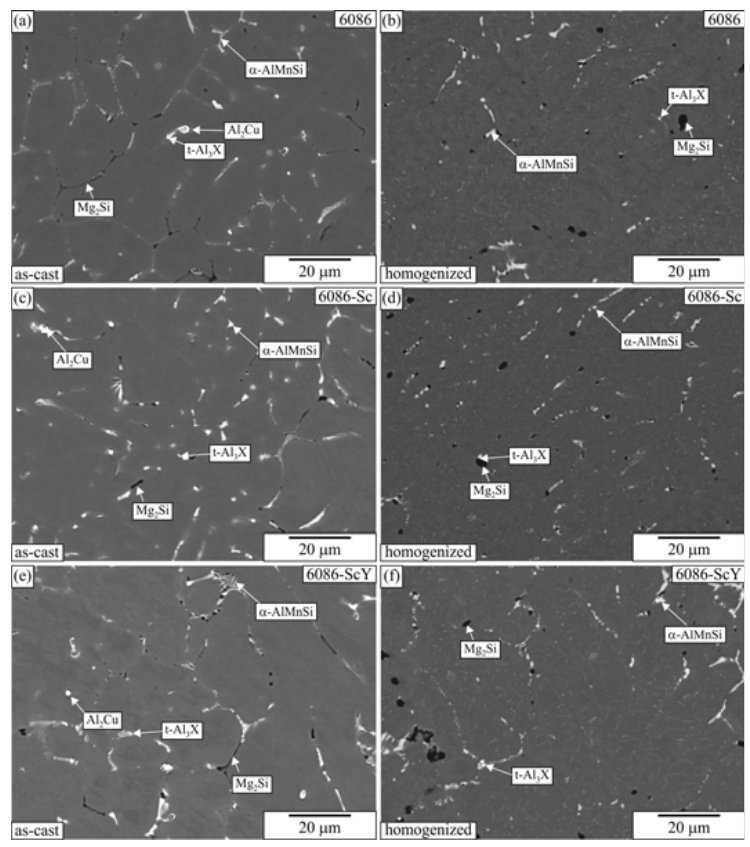
Figure 2. Microstructures of the investigated alloys in the as-cast and homogenized conditions (backsca tt ered electron micrographs, sample diameter 10 mm). ( a , b ) Alloy 6086, ( c , d ) 6086-Sc, ( e , f ) 6086-ScY.